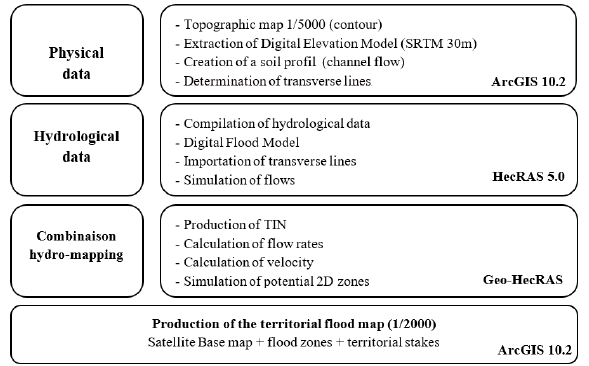
Figure 4. Process of elaboration of the flood Map